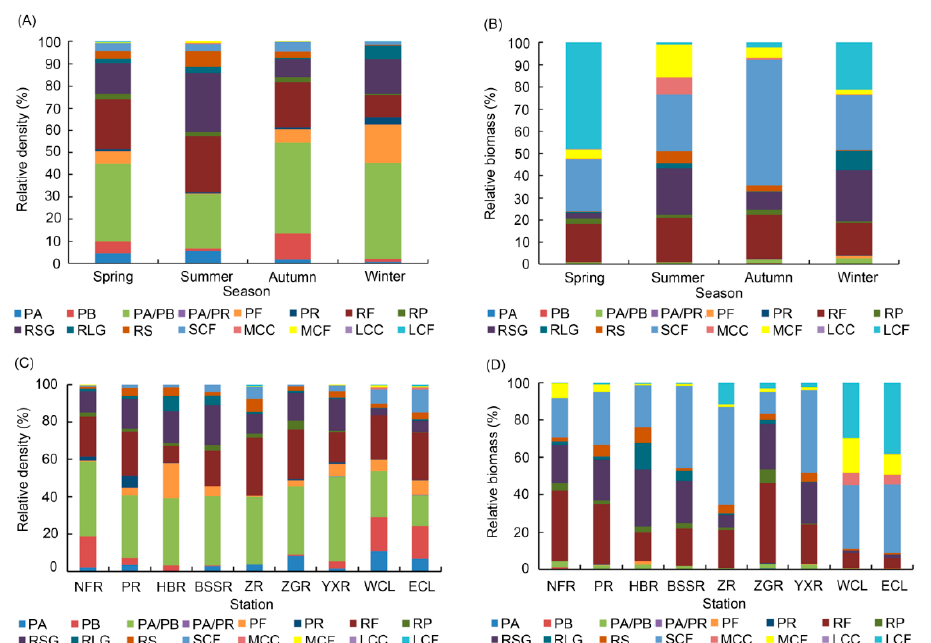
Figure 3. Seasonal and spatial variations in density and biomass of zooplankton functional groups (ZFGs). ( A ) seasonal variations in density of ZFGs, ( B ) seasonal variations in biomass of ZFGs, ( C ) spatial variations in density of ZFGs, and ( D ) spatial variations in biomass of ZFGs.